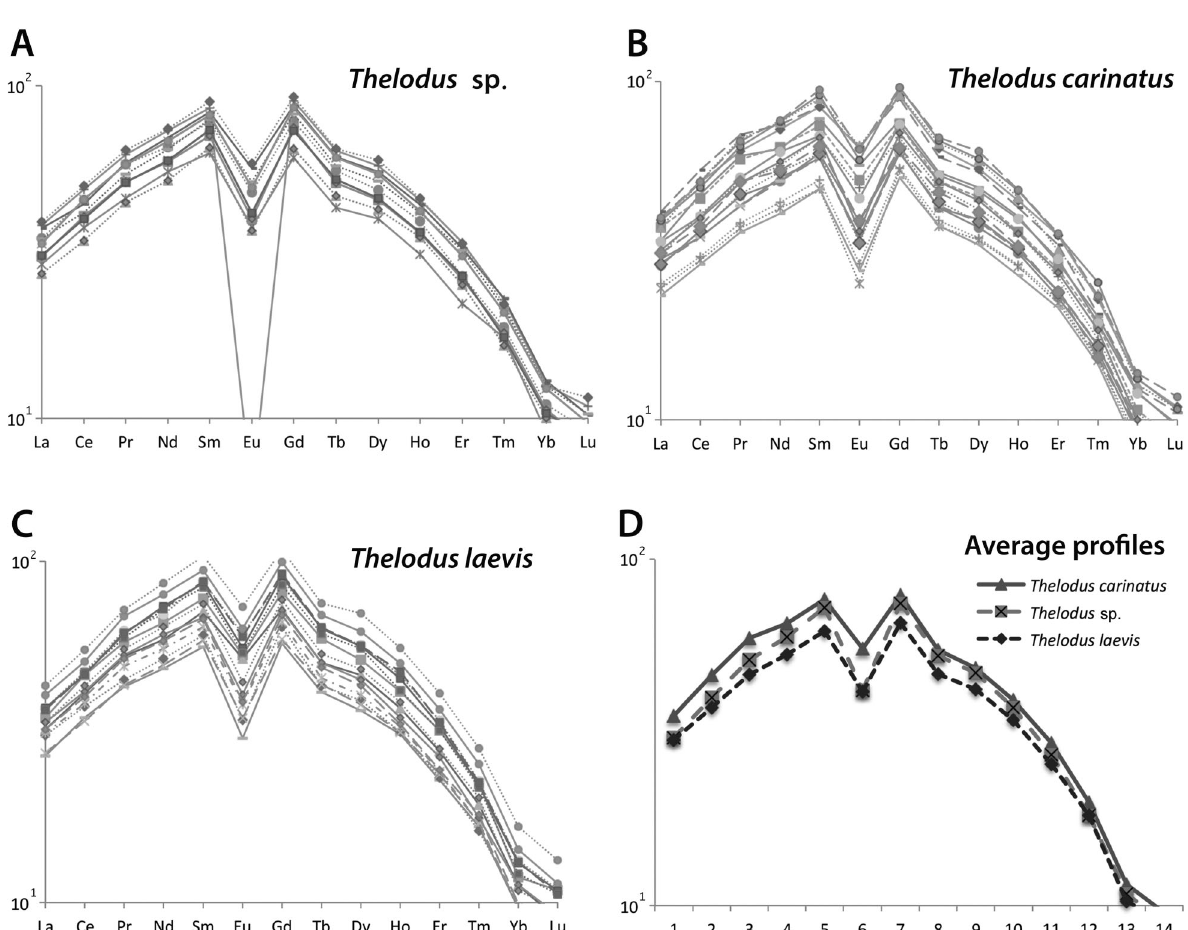
Fig. 2. Shale-normalized (PAAS) REE patterns, illustrating in situ datapoints for each studied thelodont species, obtained by LA-ICPMS: A , Thelodus sp.; B , T. laevis ; C , T. carinatus ; D , averaged REE profiles of the three species. The PAAS values taken from McLennan (1989) as follows: 38.2 (La), 79.6 (Ce), 8.83 (Pr), 33.9 (Nd), 5.55 (Sm), 1.08 (Eu), 4.66 (Gd), 0.77